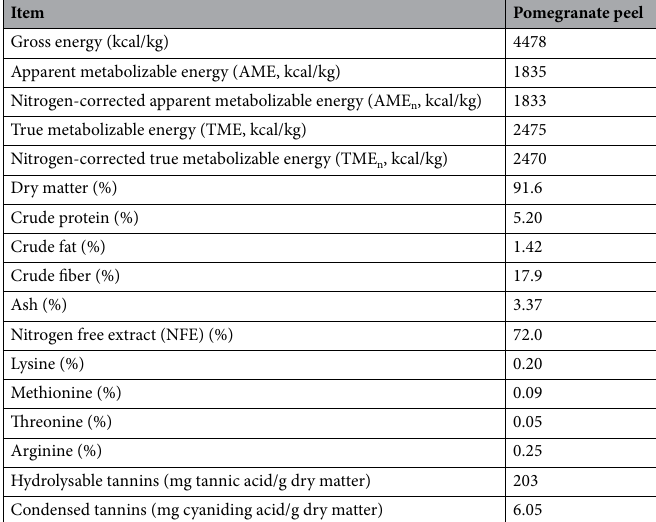
Table 4. Nutritive and chemical composition of pomegranate peel.